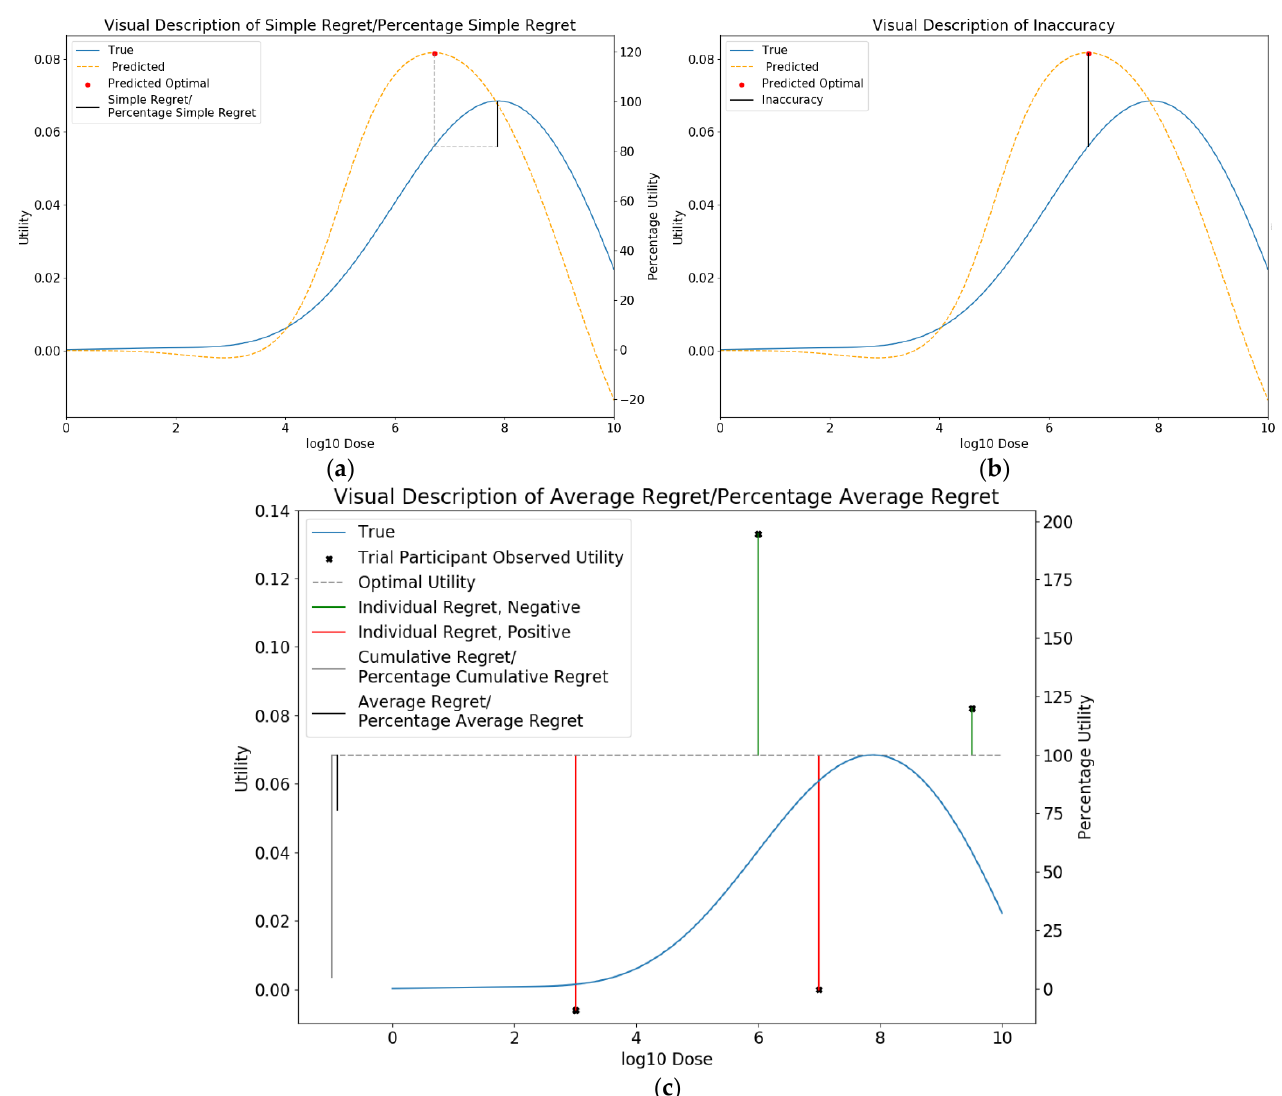
Figure 6. Visual description of ( a ) simple regret, ( b ), inaccuracy, and ( c ) average regret. Simple Regret